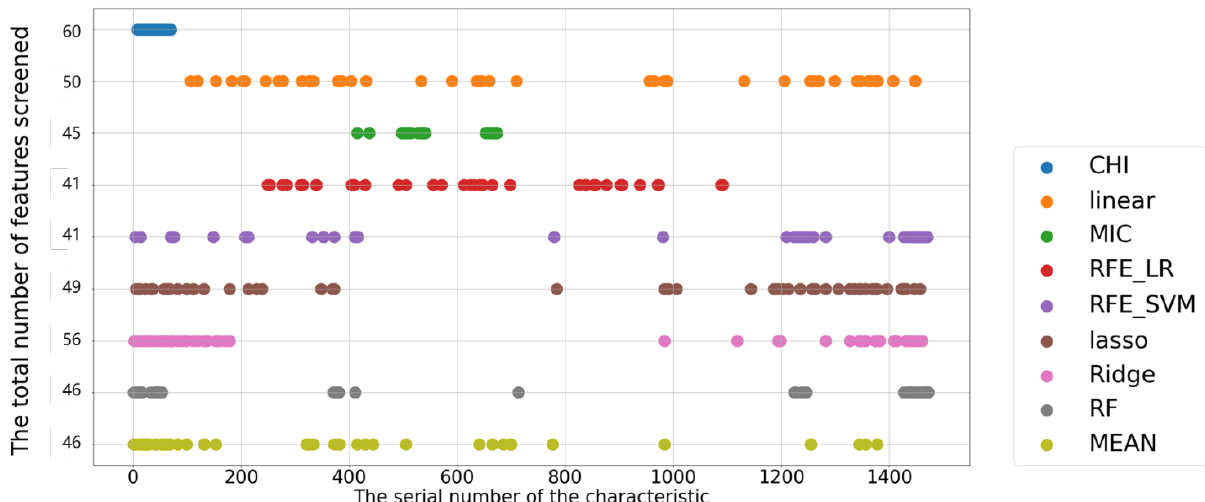
Figure 10. Results of feature selection based on spectral data.